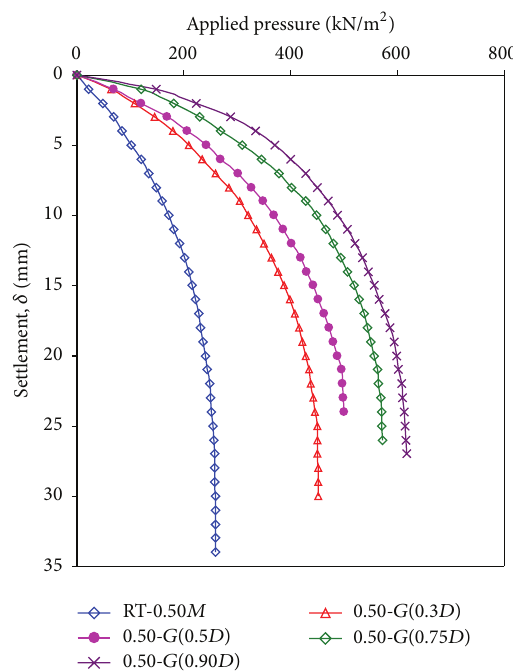
Figure 9: Load-settlement curve for Series II ( 𝐷 = 0.50 𝑀 ),